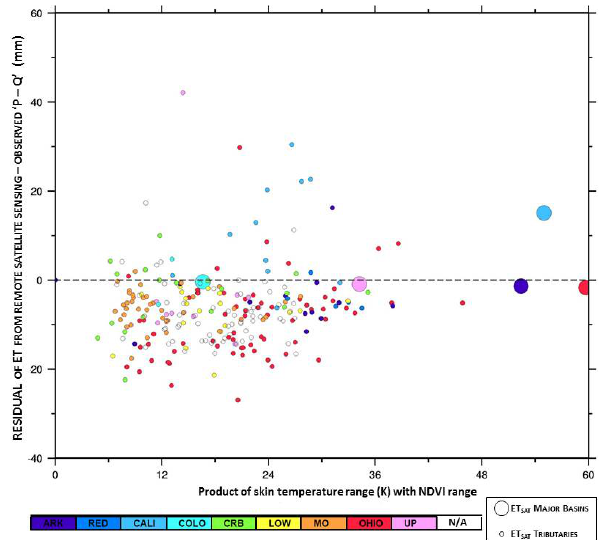
Fig. 6. Comparisons of the residual of evapotranspiration from satellite data (ET SAT – Sect. 2.2.2) with precipitation, P , minus streamflow, Q , for the major river basins (larger circles) and smaller tributaries (smaller circles) 2001–2010, as a function of VI-Ts di- versity, expressed as a product of the ranges of NDVI and skin tem- perature for each basin. Departures from the dashed line denote ei- ther an uncertainty in ET estimates, or significant long-term TWS, or other observational